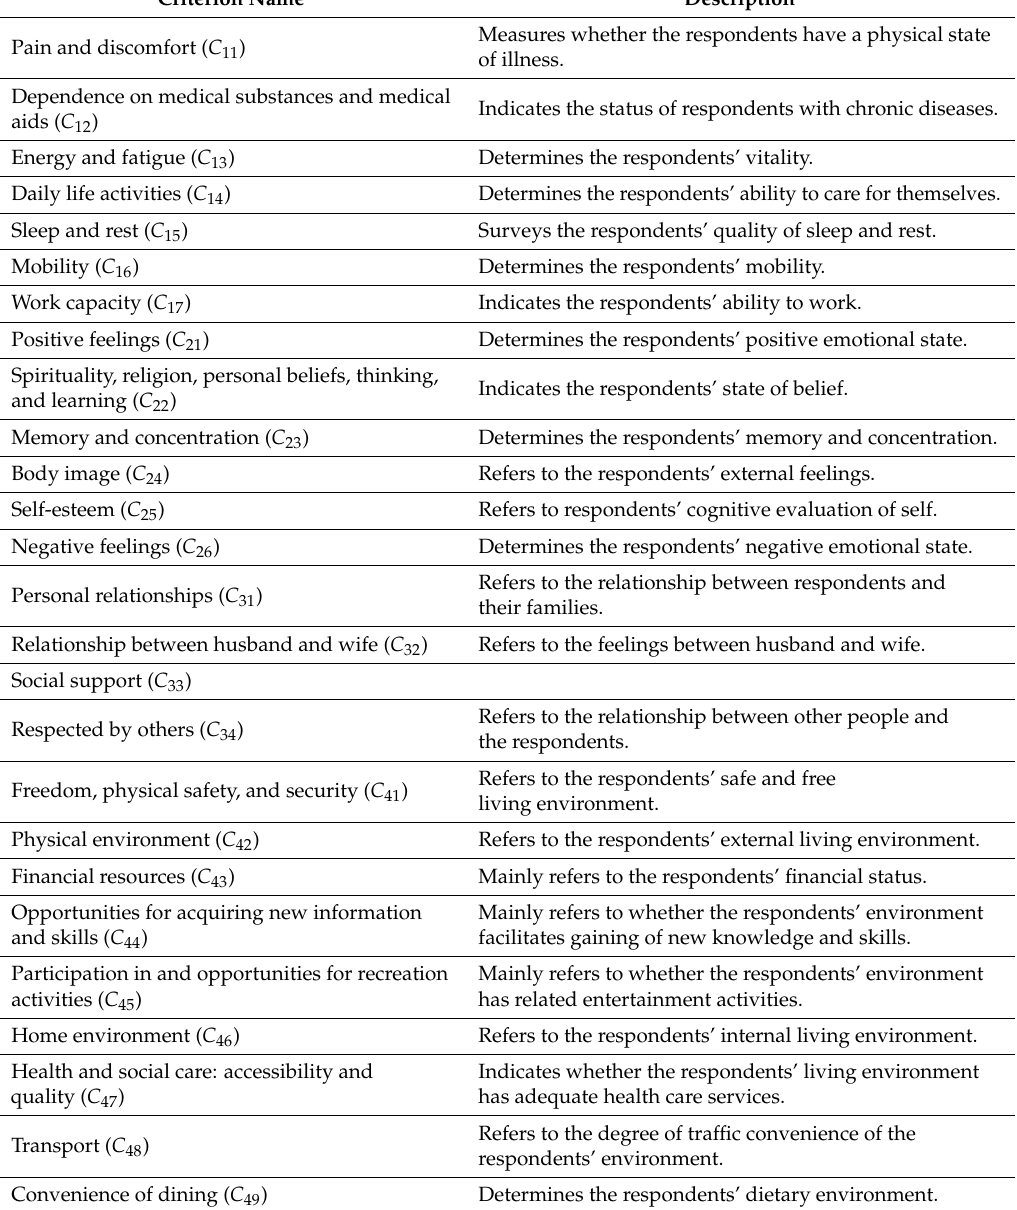
Table A1. Description of all criteria in the Chinese version of WHOQOL